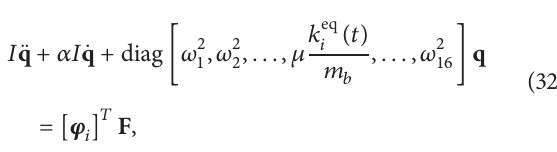
Table 1: Materials and geometric properties of rotated blades.